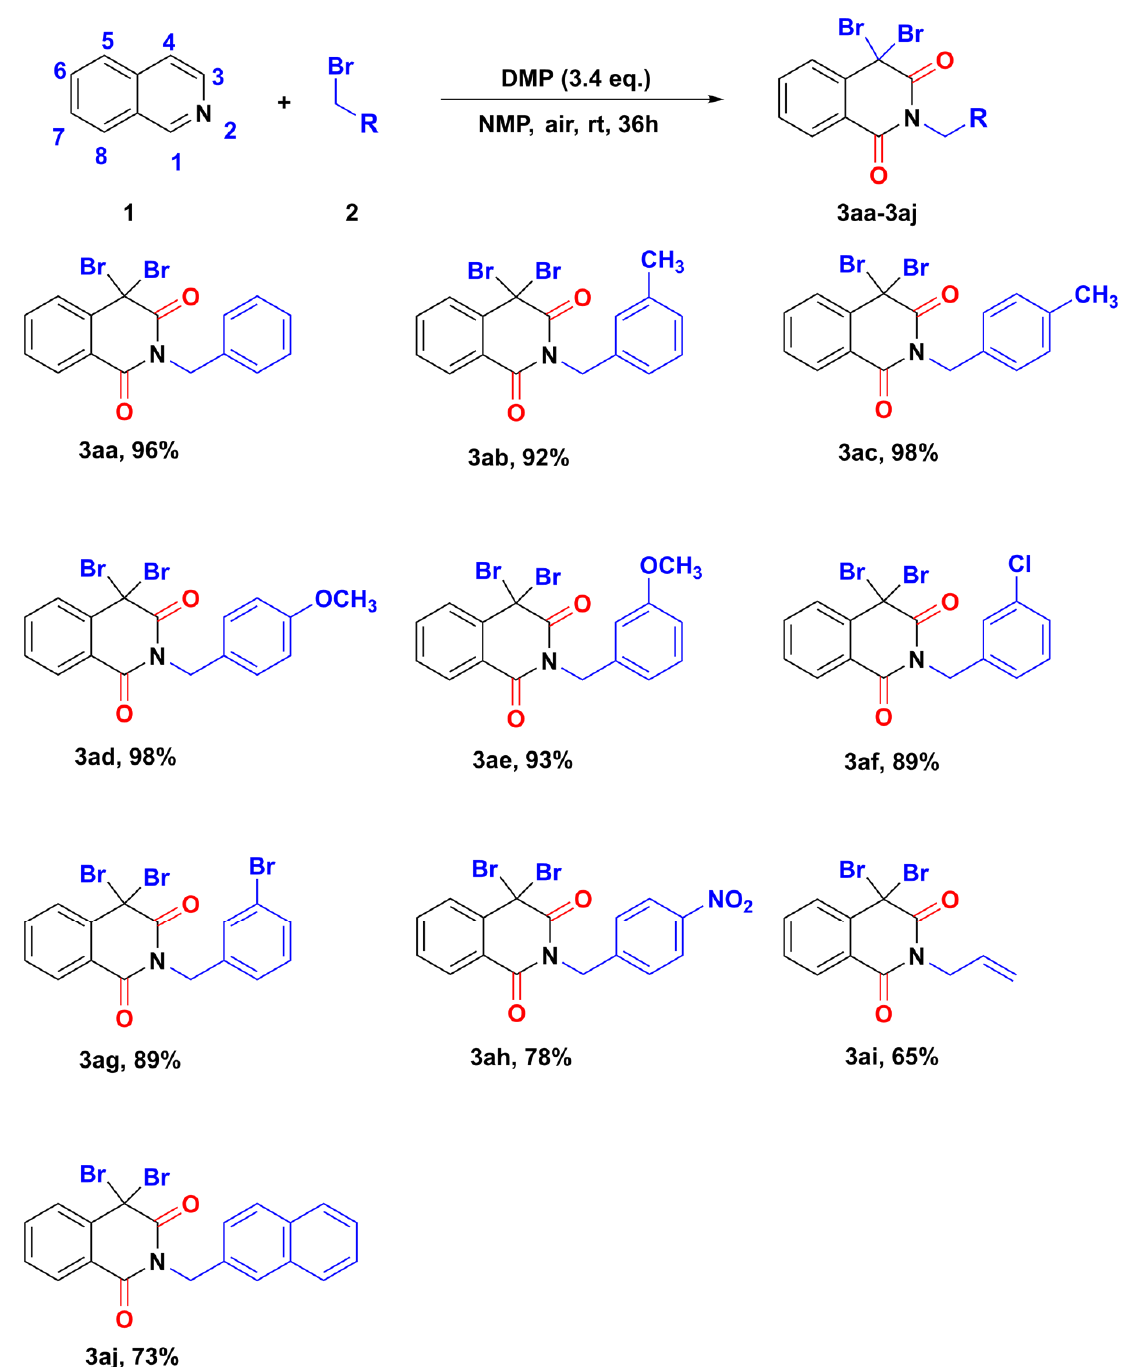
Figure 4. Investigating benzyl bromide substrates in isoquinoline oxidation coupling reaction.